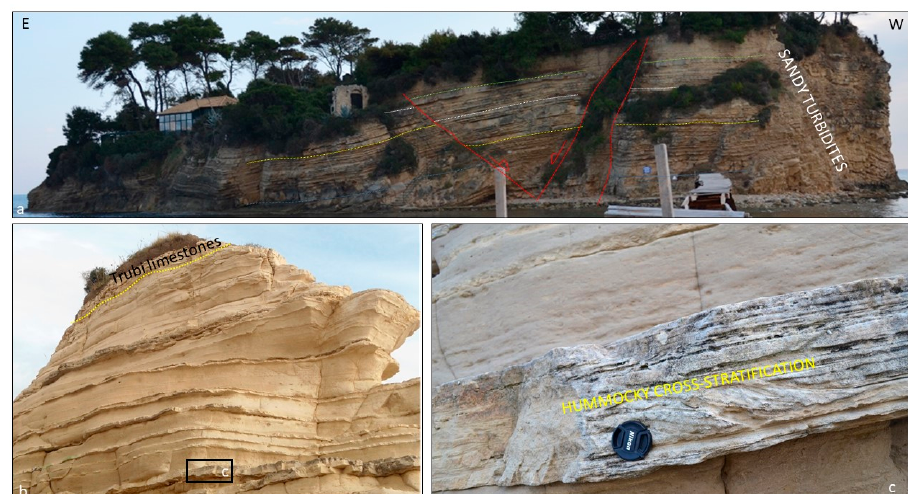
Figure 4. ( a ) The Island of Ag. Sostis where the turbiditic sandstones were outcropped. See the marked faults due to which there is no continuity from turbiditic evaporites to the post-evaporitic sequence in the harbor where the Trubi limestones ( b ) were outcropped. ( c ) Hummocky cross-stratification within the post-evaporitic sequence introducing a shelf environment.